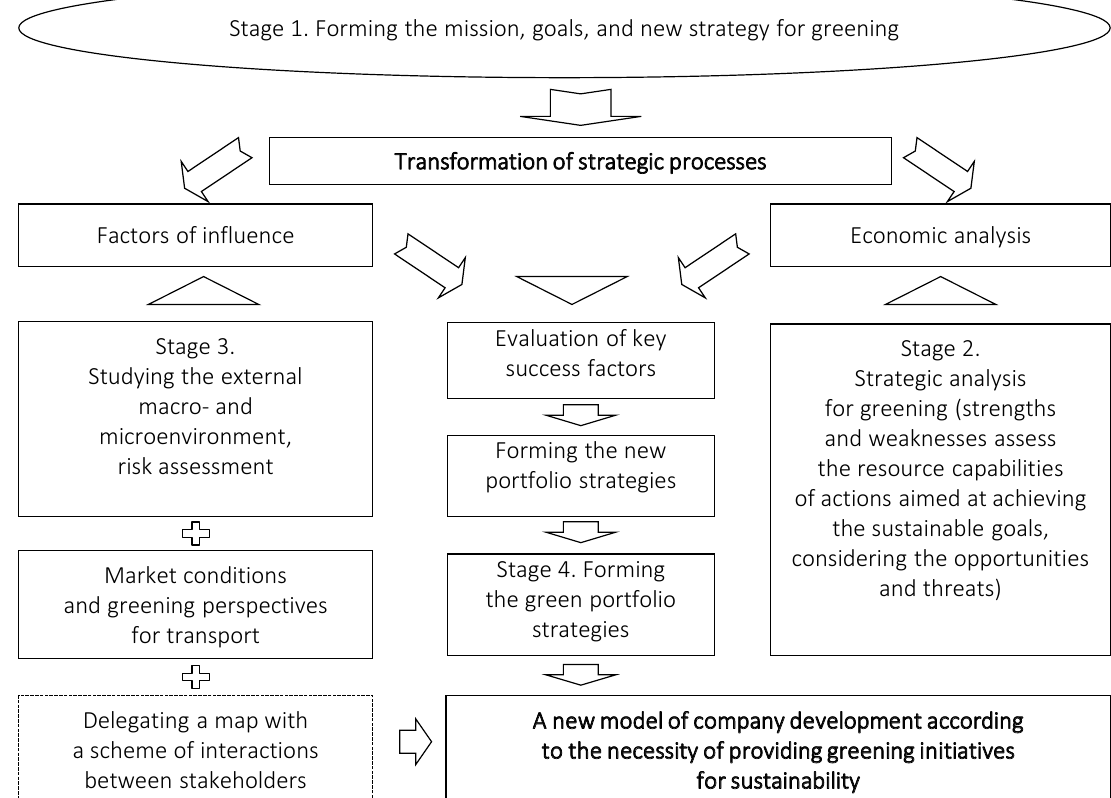
1. Forming the mission, goals, and new strategy for